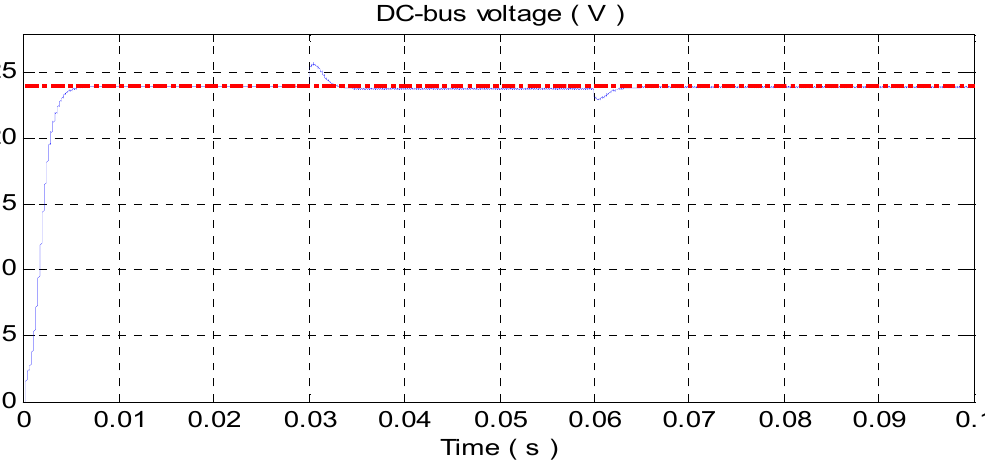
Figure 6. Voltage measurement of v dc and its reference signal V d .